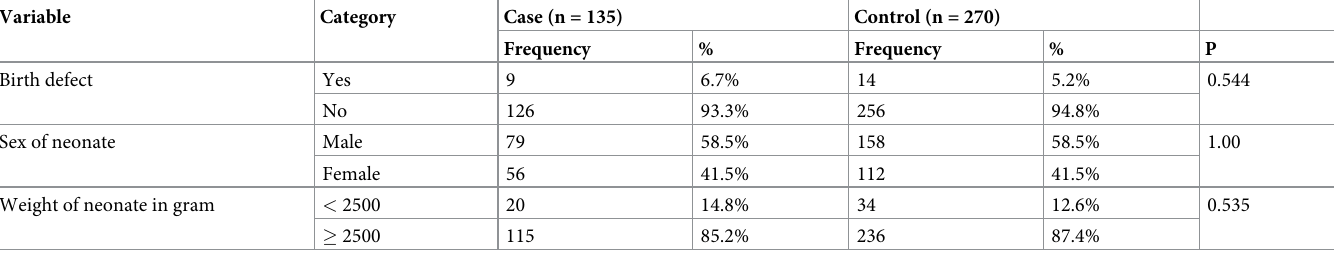
Table 4. Characteristics of a newborn delivered at public hospitals in Sidama region, Southeast Ethiopia, 2020 (n = 405).